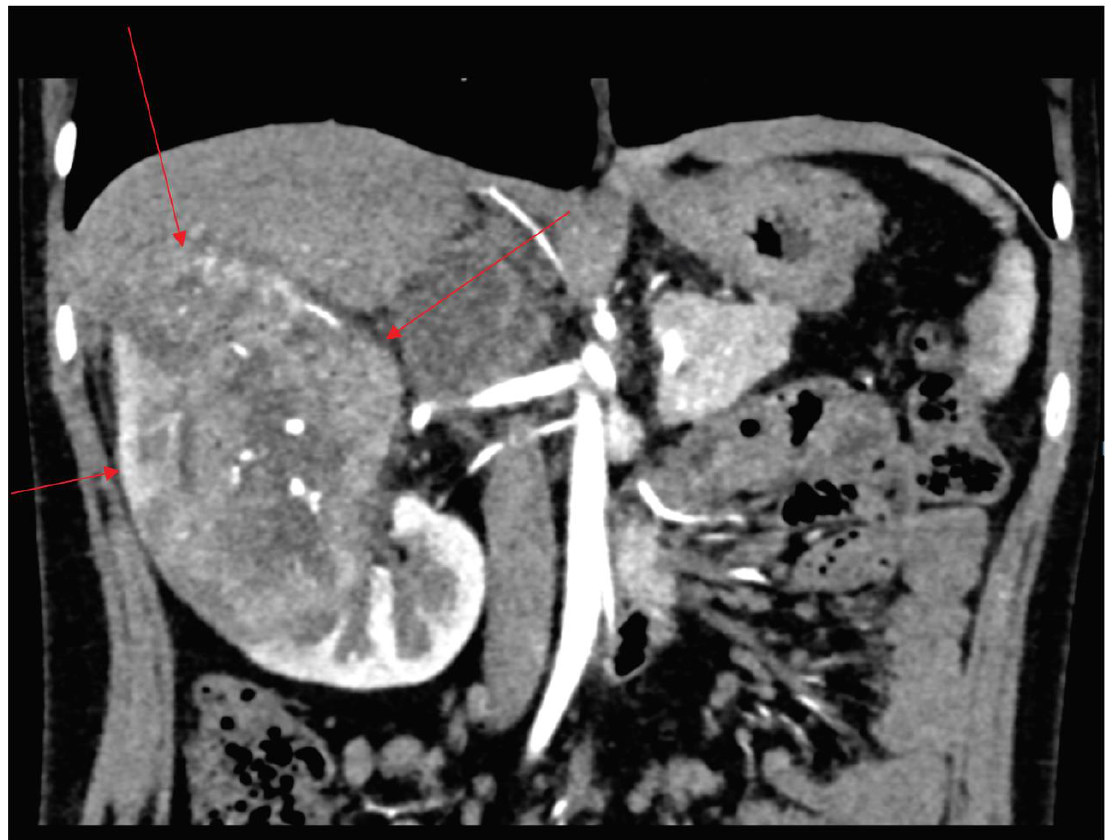
Figure 1. The abdominal computed tomography (CT) with visible the right kidney tumour (marked with an arrow), capsule rupture and right hepatic lobe infiltration.